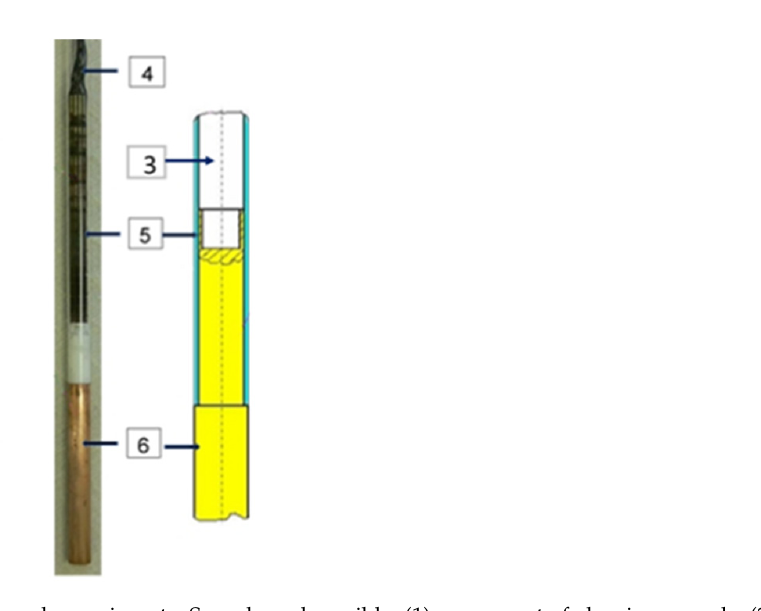
Figure 2. Ground experiments. Sample and crucible: (1) upper part of alumina capsule, (2) sample, (3) alumina capsule, (4) 12 K-type thermocouples, (5) quartz tube, (6) Cu cooling core. For the microgravity experiments, the Al-7 wt% Si alloy samples (diameter: 8 mm, length 245 mm) were inserted into Al 2 O 3 tube crucibles. The temperature distribution along the crucible was measured during the whole experiment by thirteen thermocouples (TC1–TC13) located at the outer surface of the crucible. The distance between thermocou- ples was 20 mm. The details of the cartridge are described in